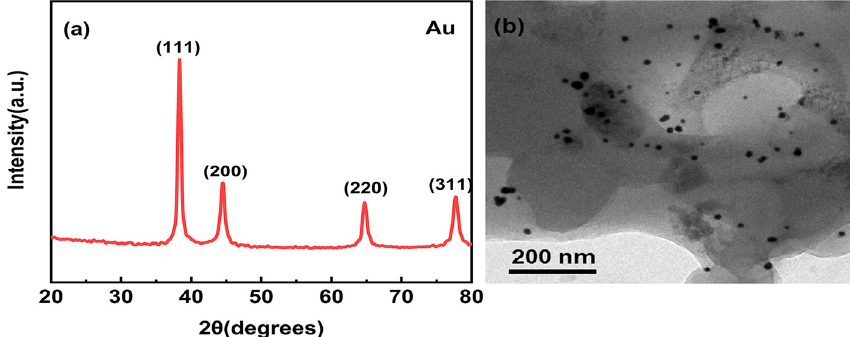
Figure 1. ( a ) XRD pattern of Au NPs; ( b ) TEM image of PF-BBO/Au NP film.